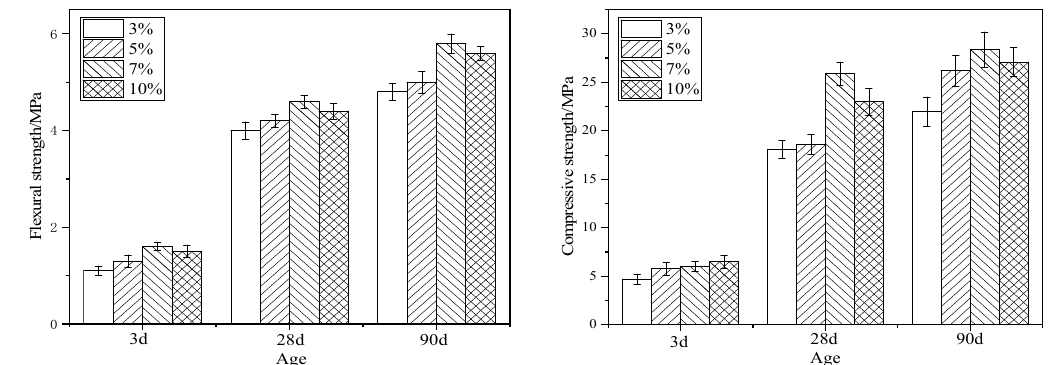
Figure 3. Strength of mortars with different gypsum contents.